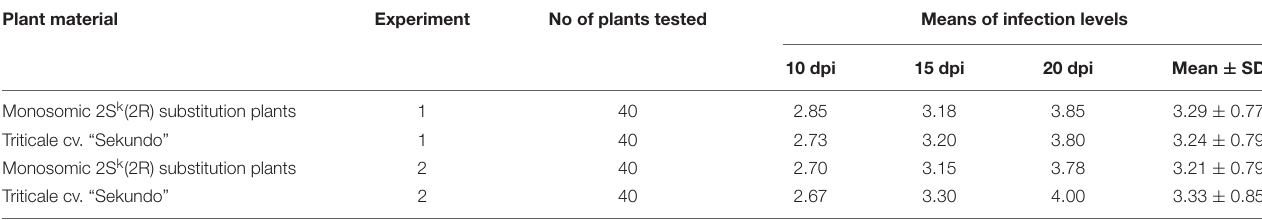
F ratio = 0.5 ( Supplementary Table 2